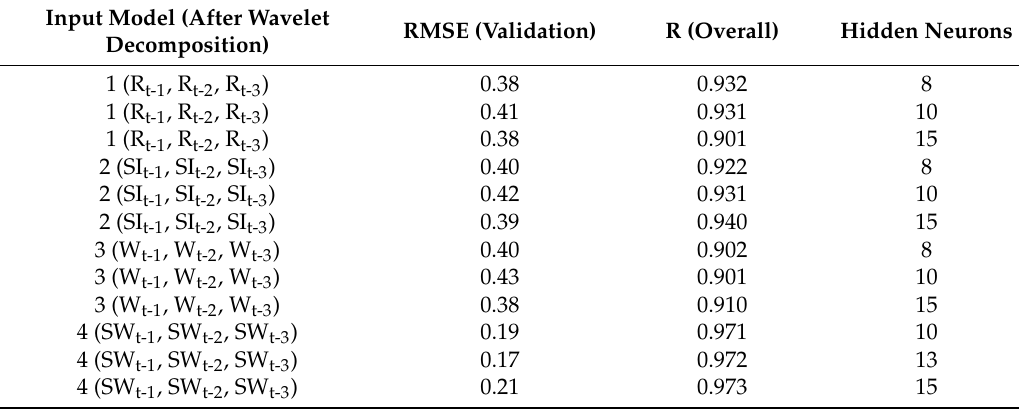
Table 9. Root mean-square error (RMSE) and R statistics of different W-ANN